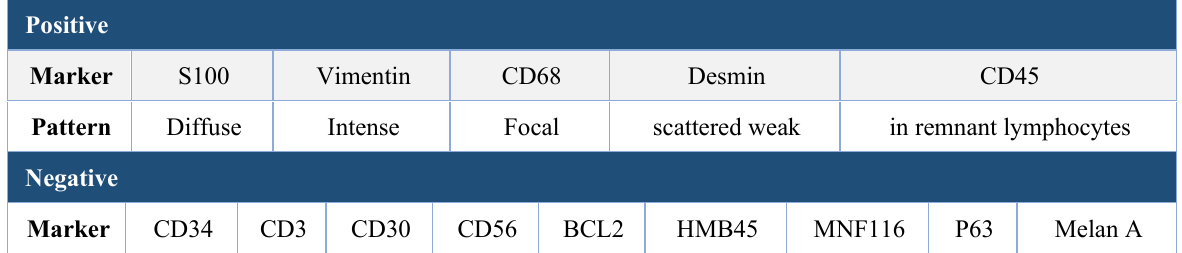
Table 2 . Markers used in this IHC